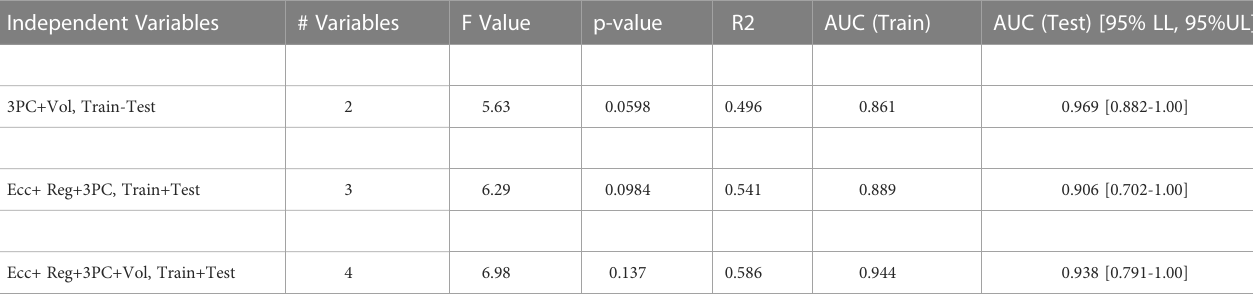
AnalysisofTrainingandTestCases,SummaryofBestRegression fi tsofcombinationsofeccentricity,SCR,andVolumetoGleasonscore.AUC,AreaUnderCurve;R2,coef fi cientofdetermination;LL, Lower Limit Con fi dence Interval; UL Upper Limit 95% Con fi dence Interval; ECC, eccentricity(0.45 ACE Threshold); Mod_Reg, Modi fi ed Regularization SCR; Reg, Regularized SCR; Vol, Volume (0.65 ACE